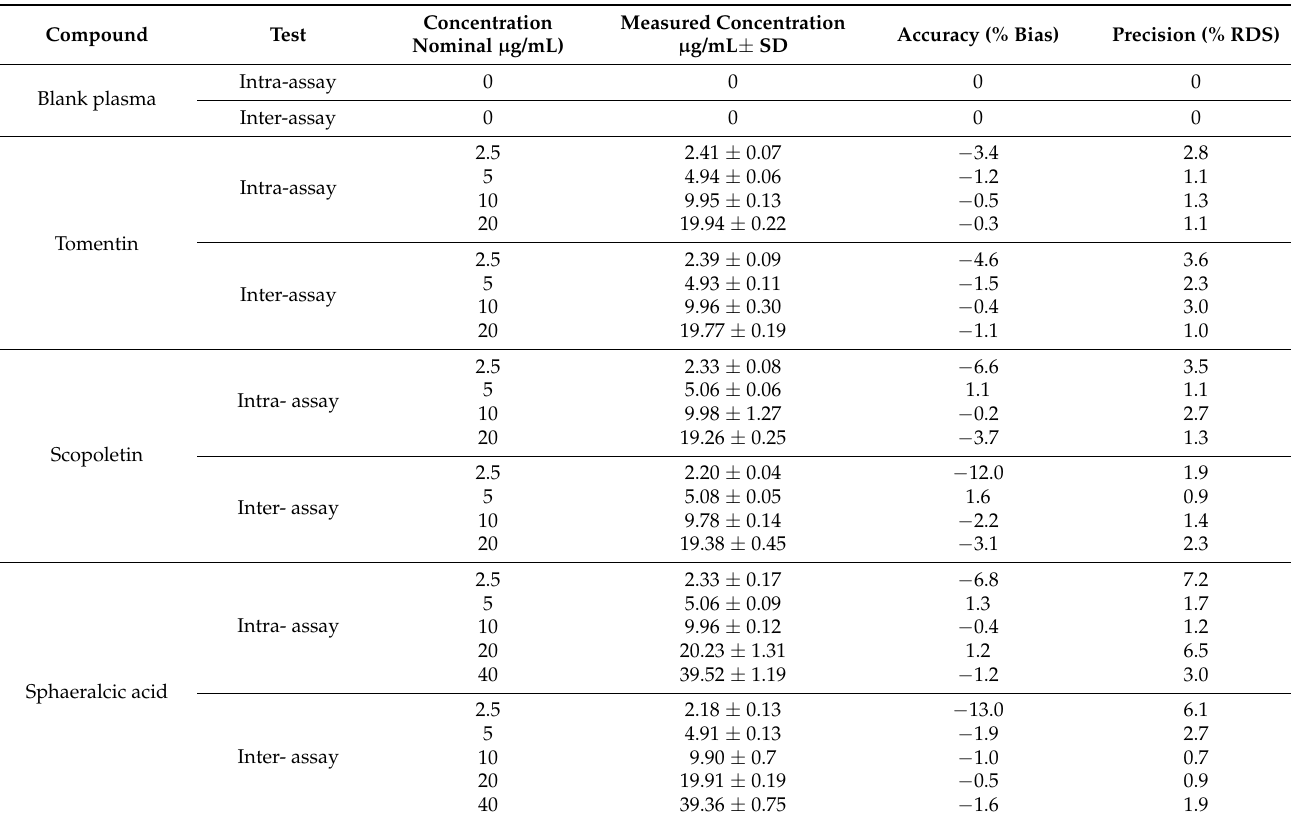
Table 1. Tomentin, scopoletin, and sphaeralcic acid by intra- and inter-assays in mice measured in plasma (matrix), and precision and accuracy